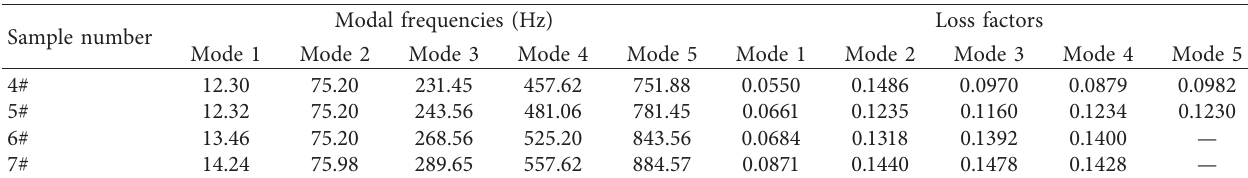
Table 5: Modal frequencies and loss factors of 4# ∼ 7 # (experimental temperature: 23.5 ° C). Sample